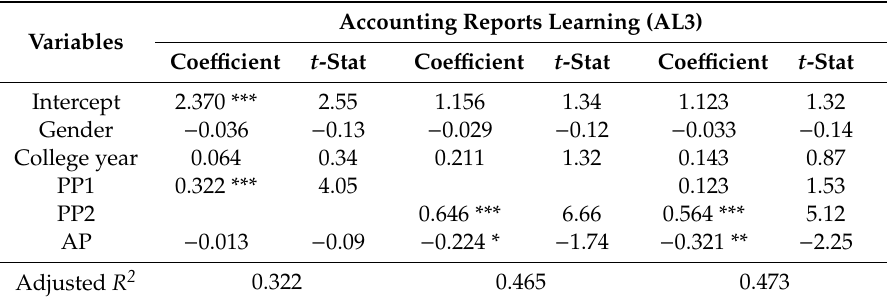
Table 10. E ff ect of positive perception on accounting reports learning—mediating e ff ect.